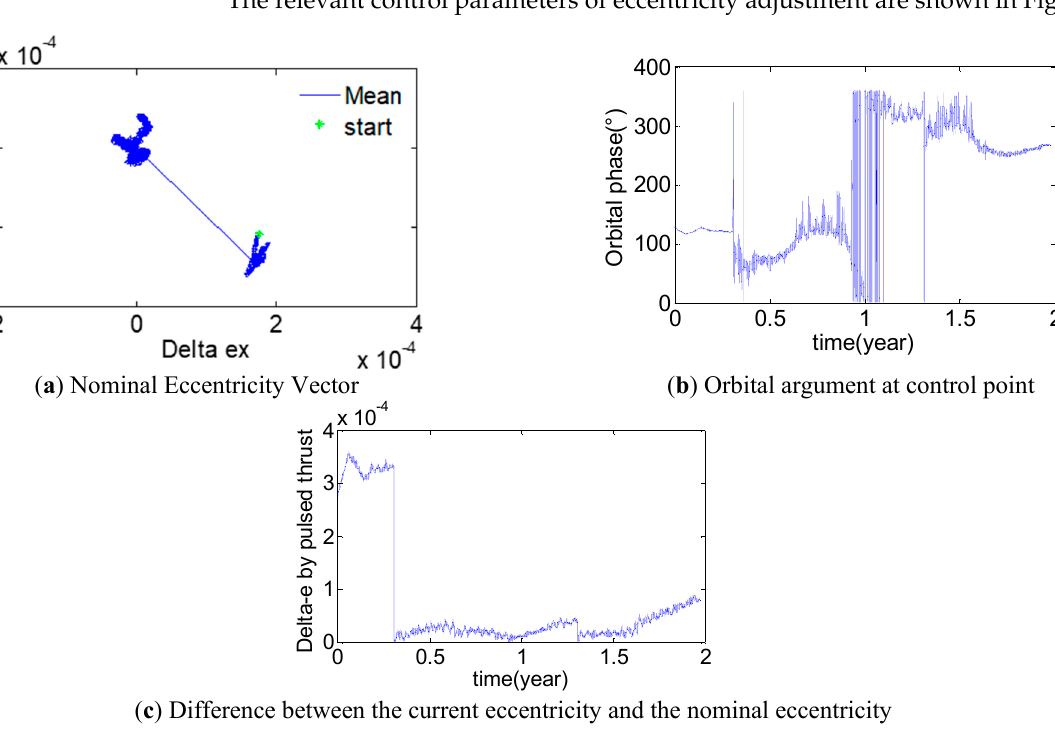
Figure 6. Control parameters for eccentricity adjustment.